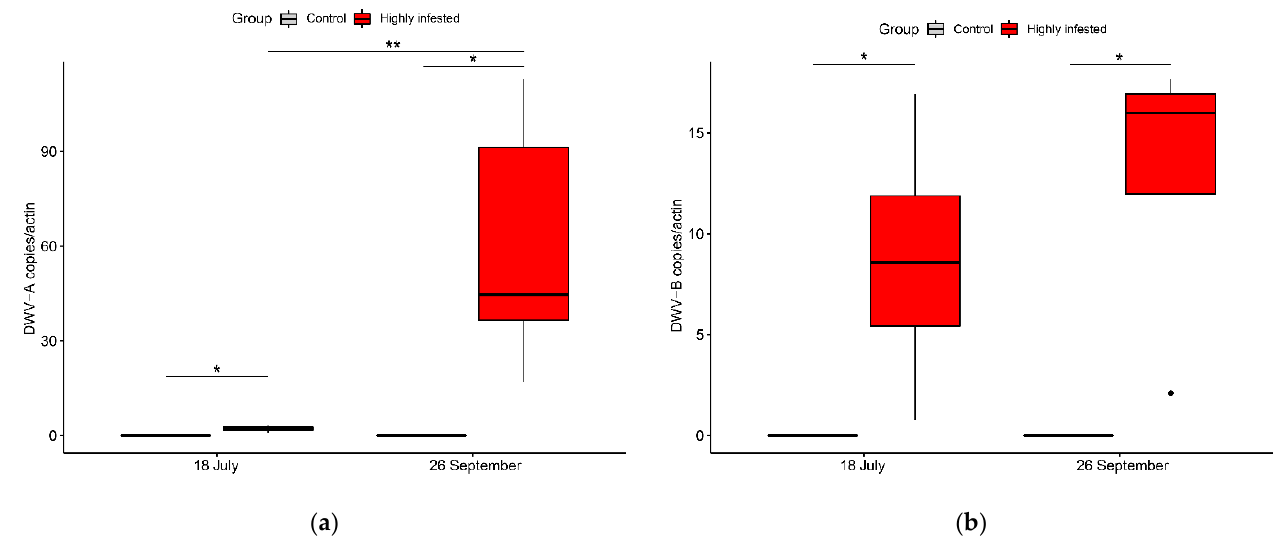
Figure 3. DWV loads on July and September in honeybees of highly infested and control hives: ( a ) DWV-A loads (copies/actin); ( b ) DWV-B loads (copies/actin). Overall, a predominance of DWV variant A is seen. DWV-A and DWV-B copies/actin were significantly higher in infested hives than in controls (*, p < 0.05, Mann – Whitney test), with a significant increase over time (**, p = 0.001, Wilcoxon test) for DWV-A.